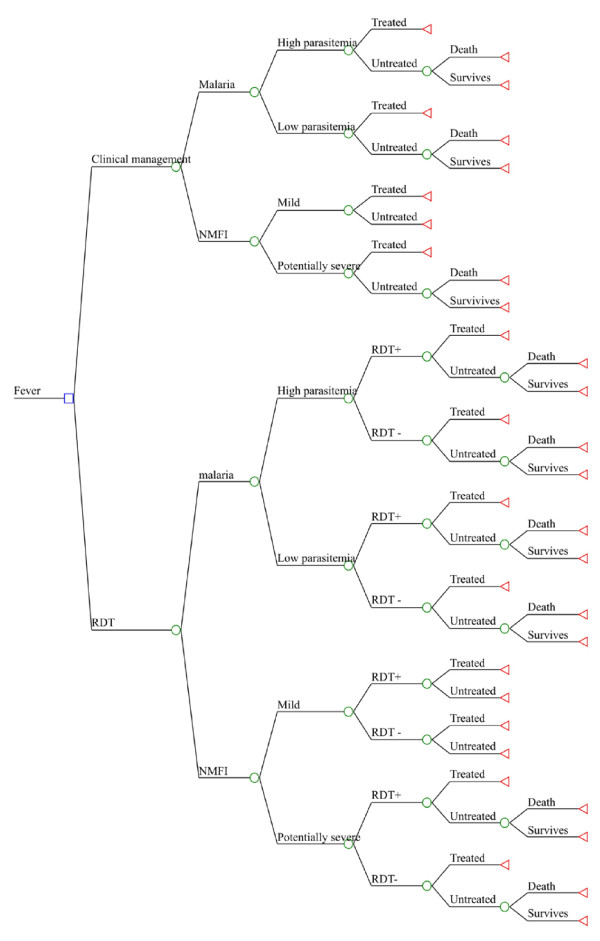
Structure of the Decision Tree.